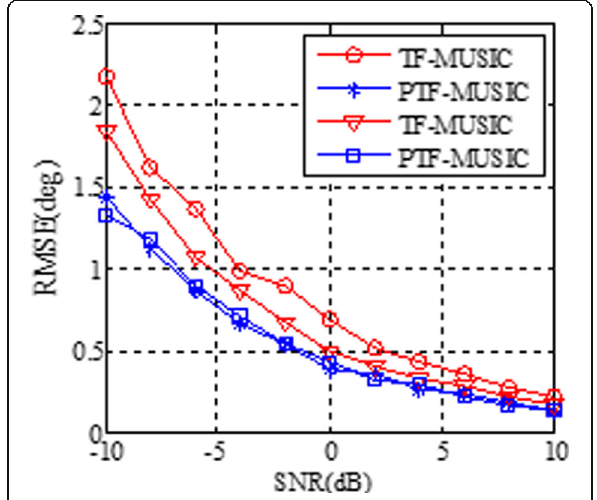
Fig. 5 RMSE of TF MUSIC and PTF MUSIC